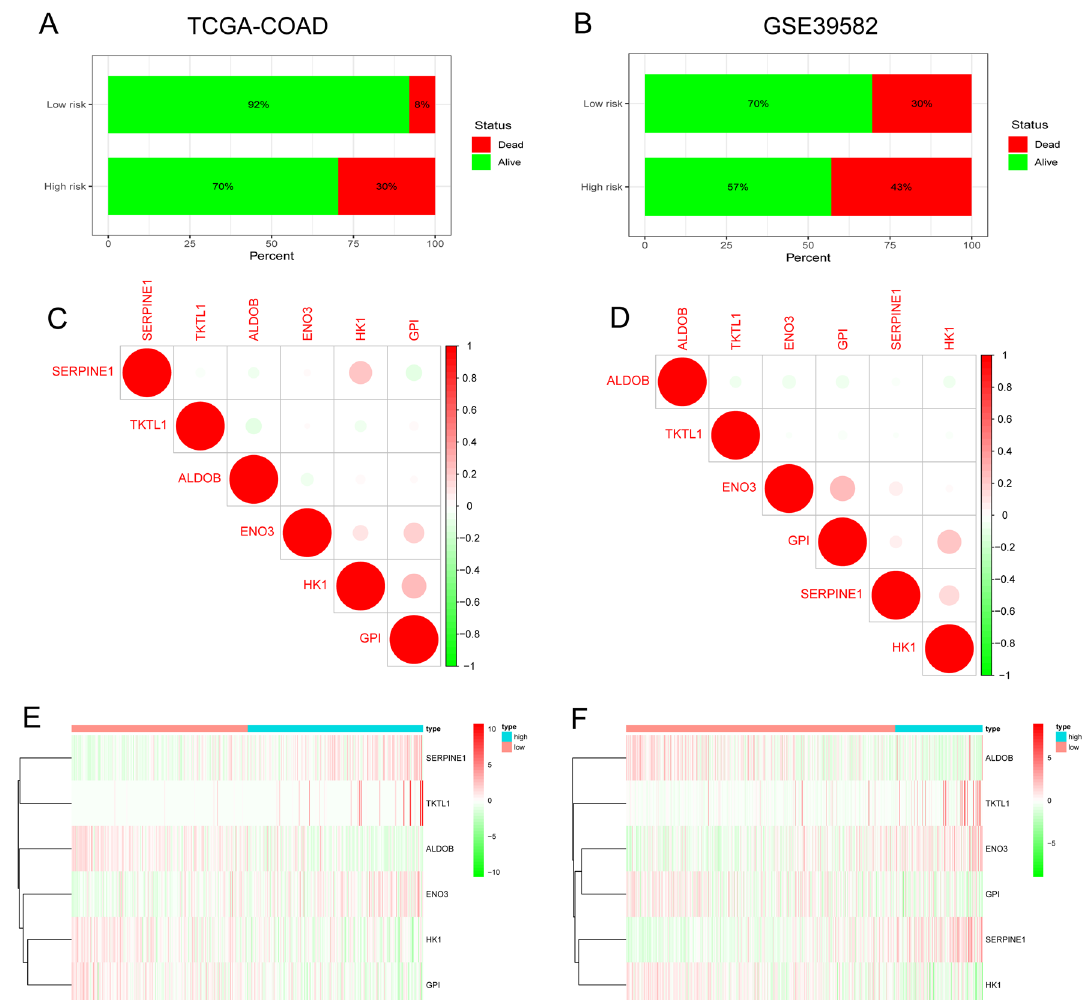
Figure 3. Prognostic HRG model verification. Percentage survival status for the low- and high-risk groups in the ( A ) TCGA and ( B ) GEO datasets. Correlation analyses of the signature’s six HRGs in the ( C ) TCGA and ( D ) GEO datasets. ( E , F ) Heatmaps of the six HRGs in the GEO